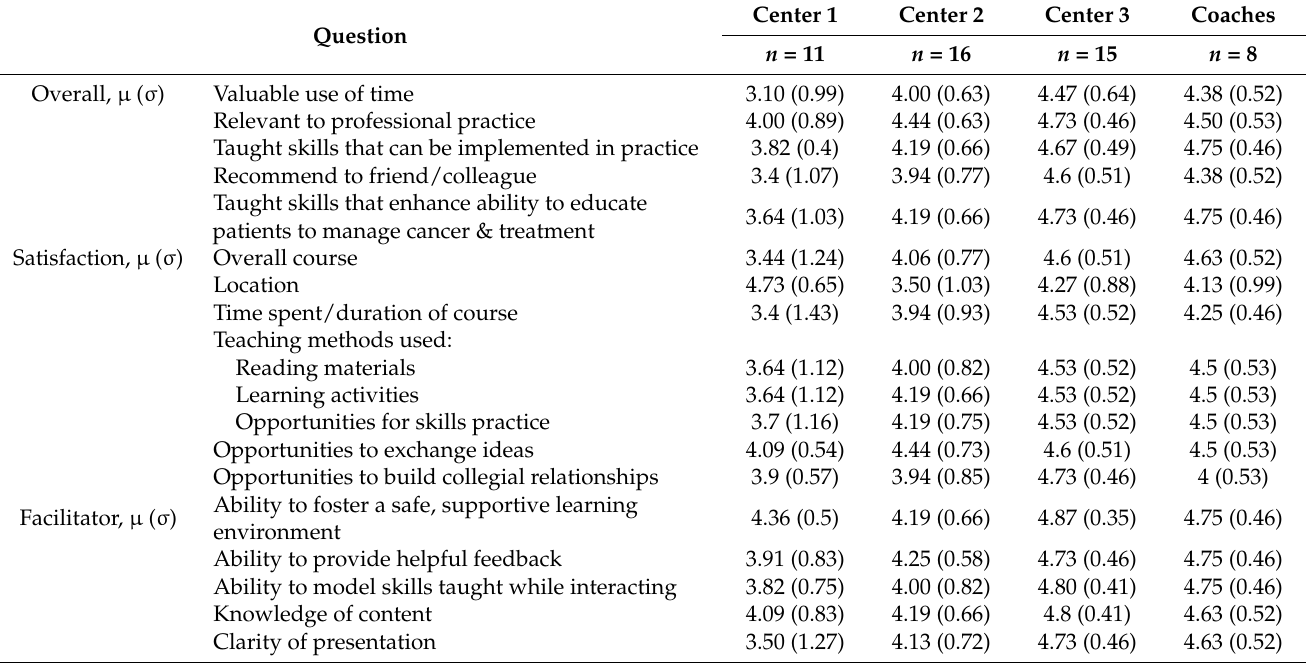
Table 4. Study participants’ evaluation of self-management support training by center and for